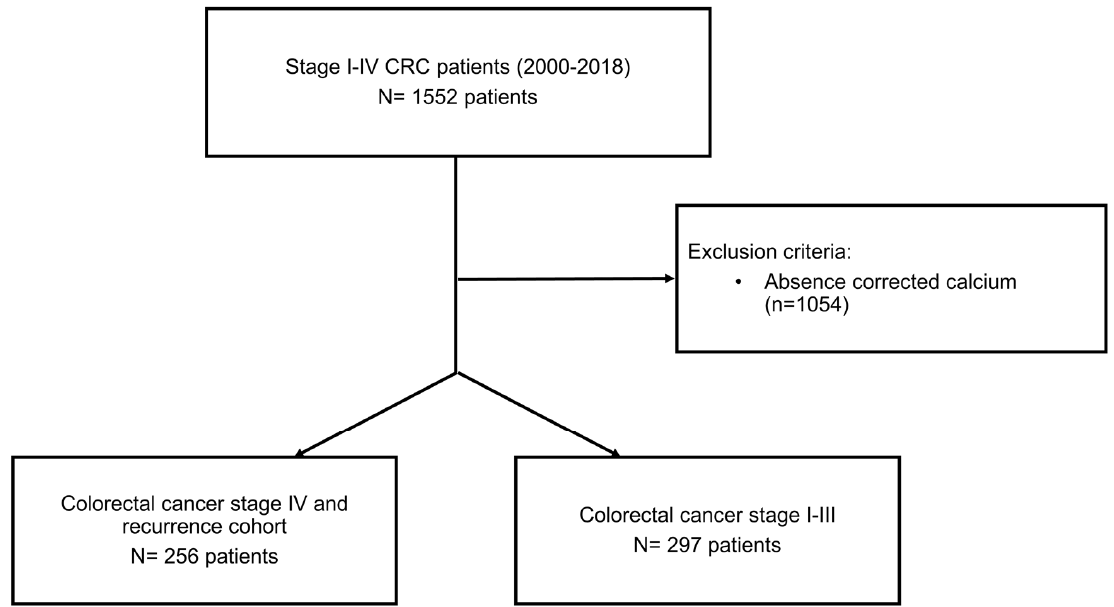
Figure 1. Study Figure 1. Study flowchart.